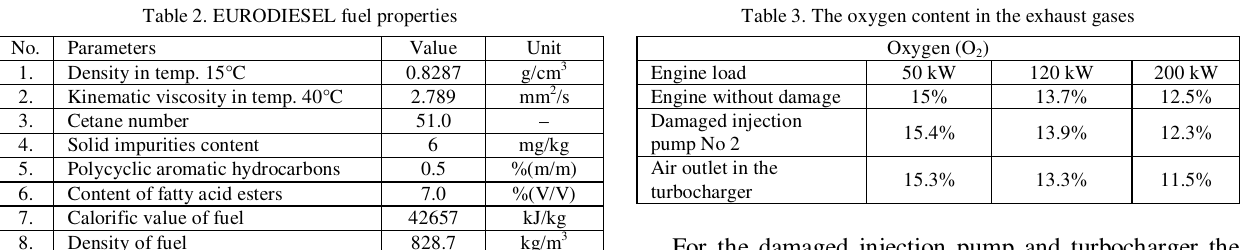
Table 2. EURODIESEL fuel properties